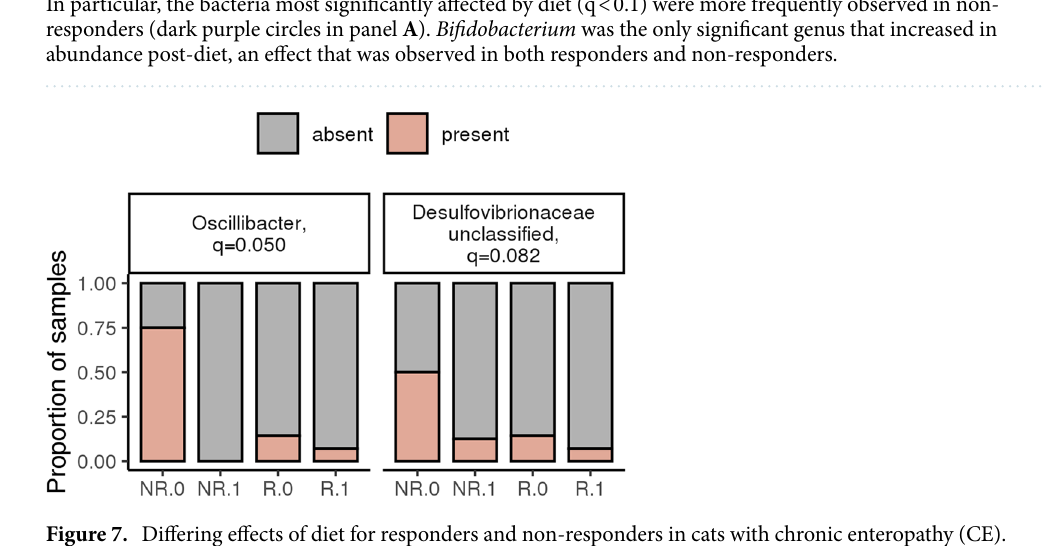
Figure 7. Differing effects of diet for responders and non-responders in cats with chronic enteropathy (CE). There are a limited number of significant interaction terms, where the only significant genera are Oscillibacter and Desulfoviberionaceae_unclassified . Both are most prevalent in non-responders at baseline and are rarely observed post diet in both non-responders and